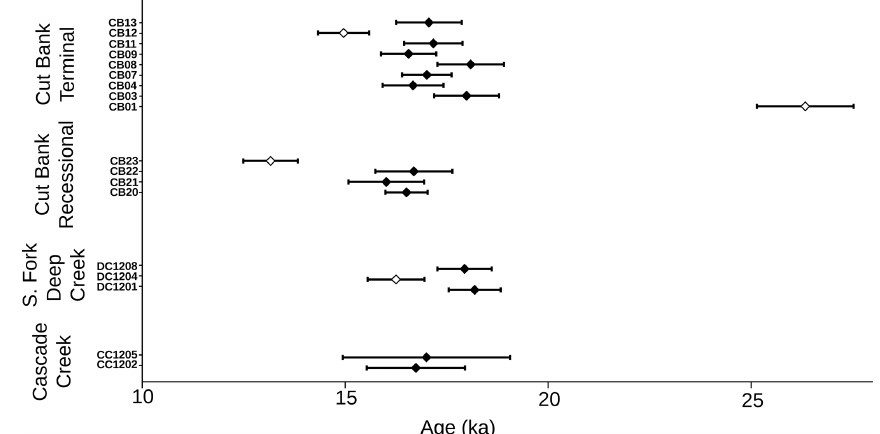
Figure 5. Cosmogenic 10 Be exposure ages with analytical uncertainties for samples collected from moraines at Cascade Creek and South Fork Deep Creek in the Absaroka Range and moraines at Cut Bank in the Lewis Range. Samples that have been identified as outliers are denoted by open